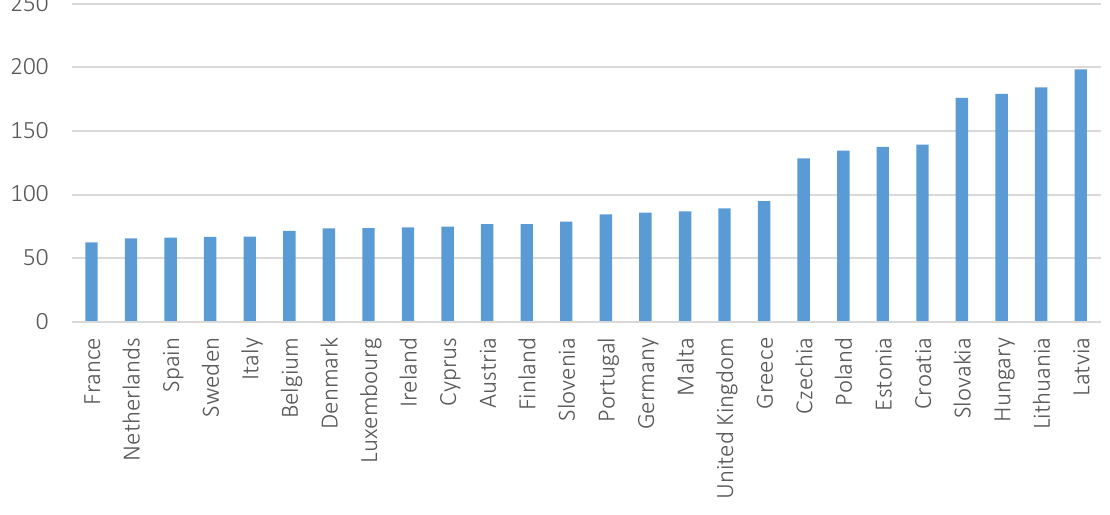
Table 2. Mann-Whitney U-Test of the effectiveness of selected EU countries